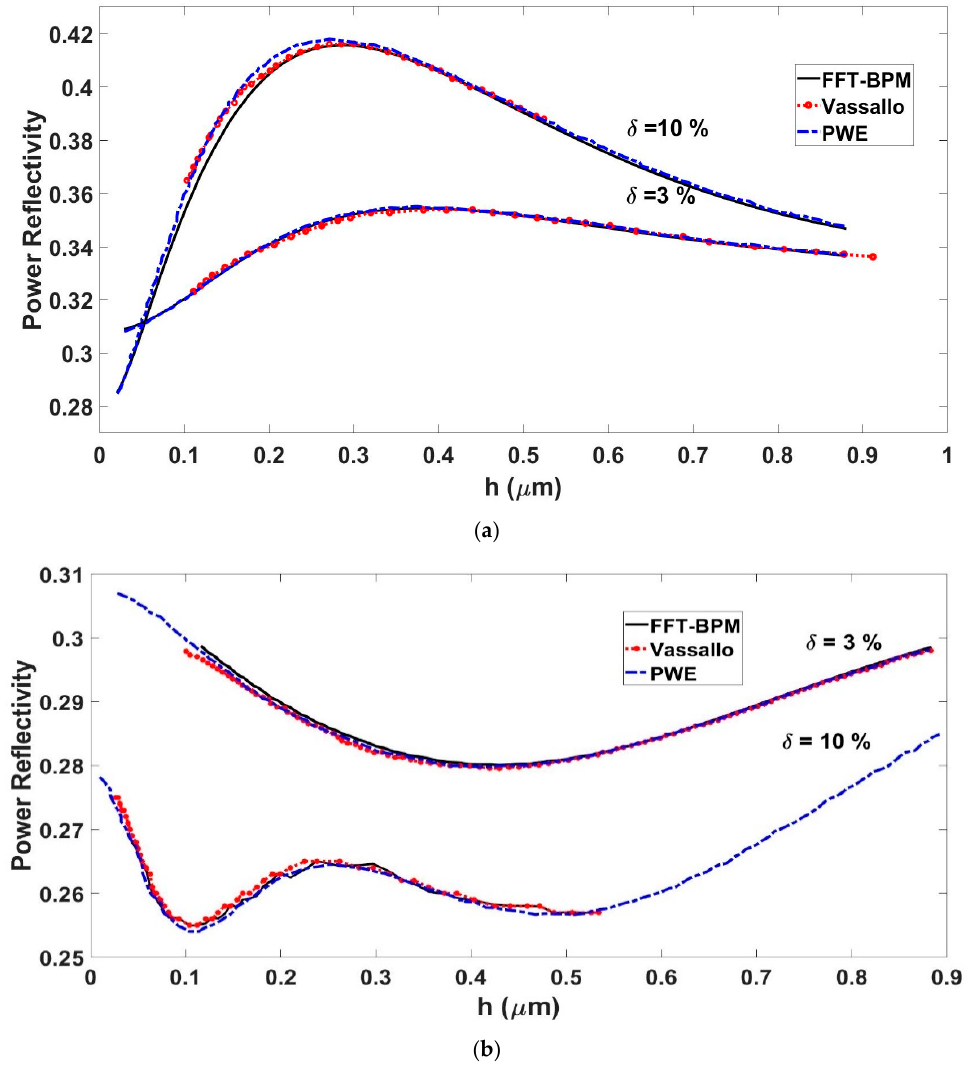
Figure 2. The power reflectivity curve comparison between our proposed method and Vassallo [15], and plane wave expansion (PWE) techniques [24] at ( a ) transverse electric (TE) polarization case, ( b ) transverse magnetic (TM) polarization case.